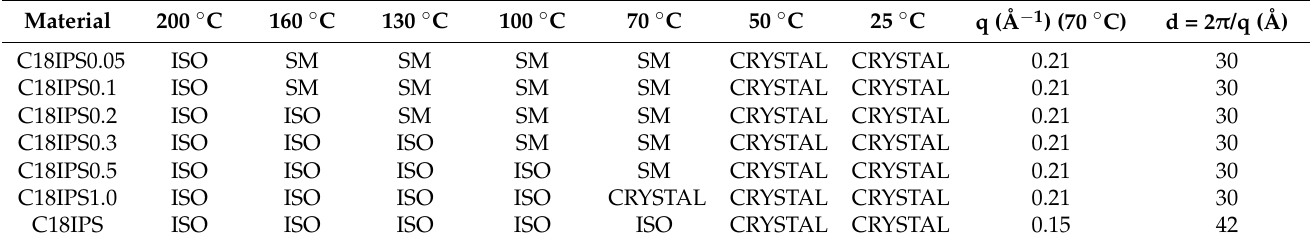
Table 4. Summarized phases (ISO = isotropic, SM = smectic, and CRYSTAL = crystalline) of blended electrolytes containing C18IPS as shown through SAXS and WAXS measurements at each measure- ment temperature while cooling. Values of the scattering vector for the first major peaks and the corresponding d-spacing values at 70 ◦ C are also